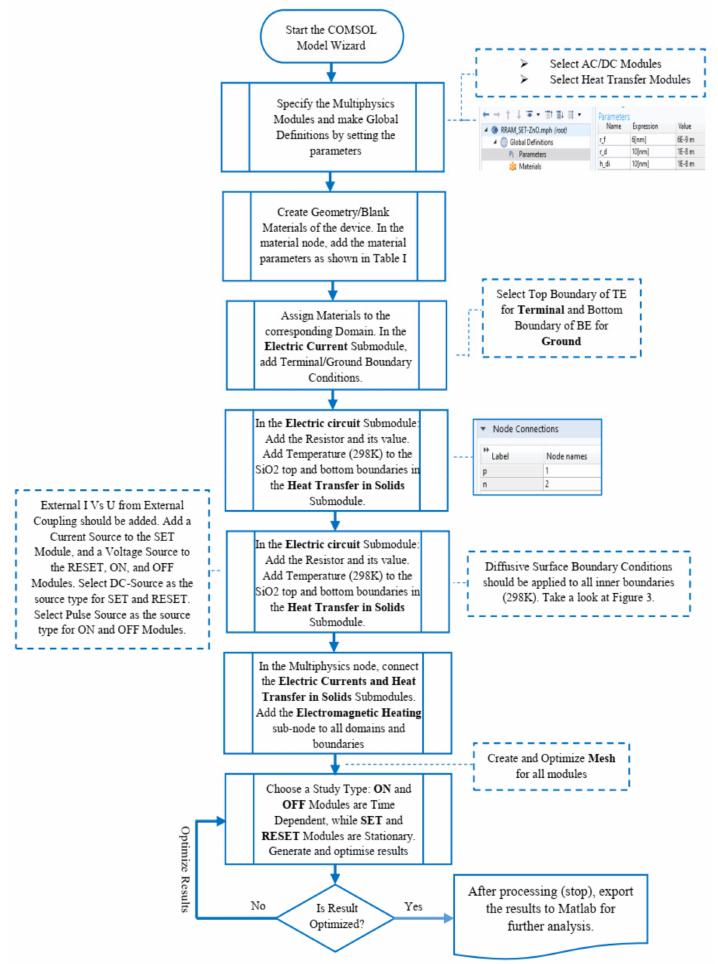
Figure 4. Flow chart of the implementation processes in COMSOL